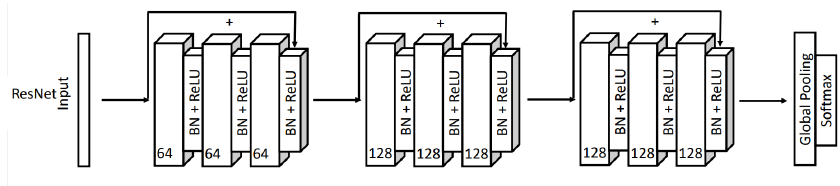
Figure 4. ResNet model architecture.